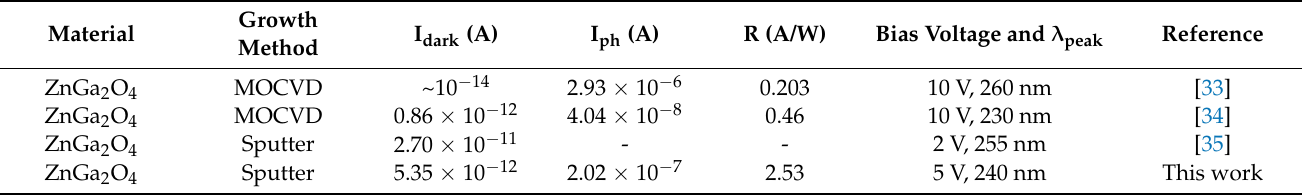
2 O 4 PD with other previously reported ZnGa 2 O 4 PDs.